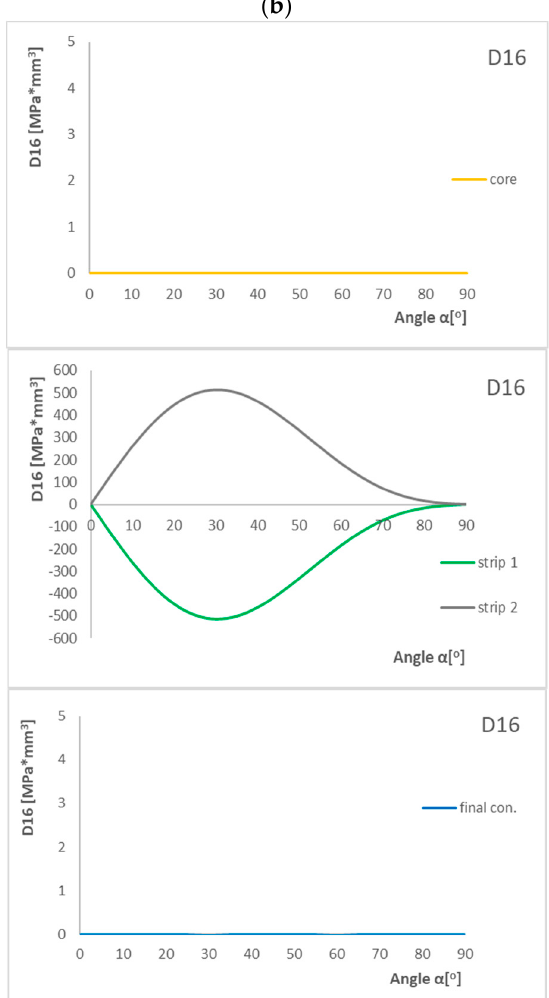
Figure 6. Influence of layer angle α in laminate with PN1 stacking sequence on D c coefficient ( a ) for core and ( b ) for strips and final configuration. Figure 7. Influence of layer angle α in laminate with PN1 stacking sequence on B t coefficient ( a ) for core and ( b ) for strips and final configuration.